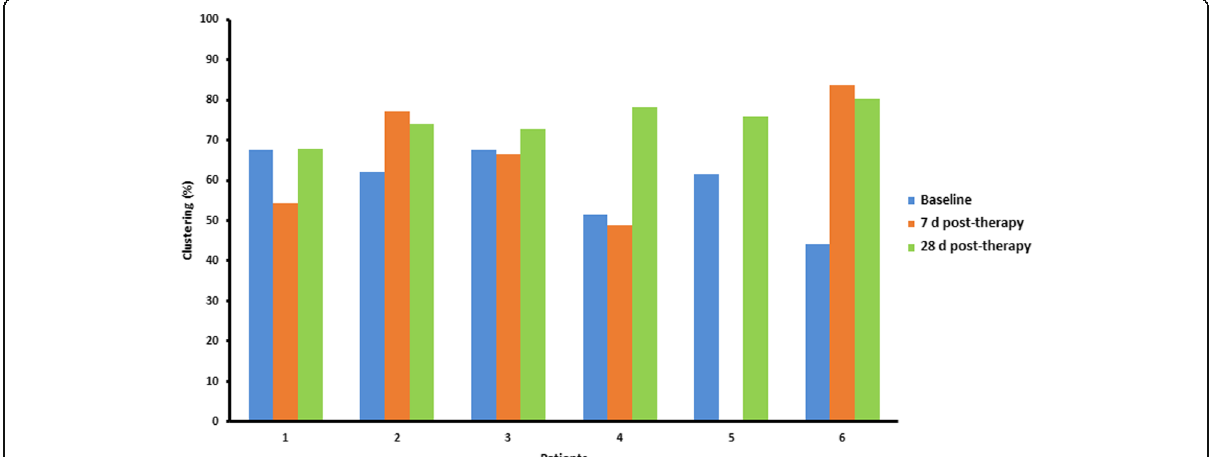
Fig. 5 Clustering (%) represents the degree of voxel clustering for all lesions, for the three time points: baseline, 7 days post-therapy and 28 days post-therapy. Voxels are more clustered when the percentage is closer to 100%. *TBF data for patient 5 was unavailable and therefore the